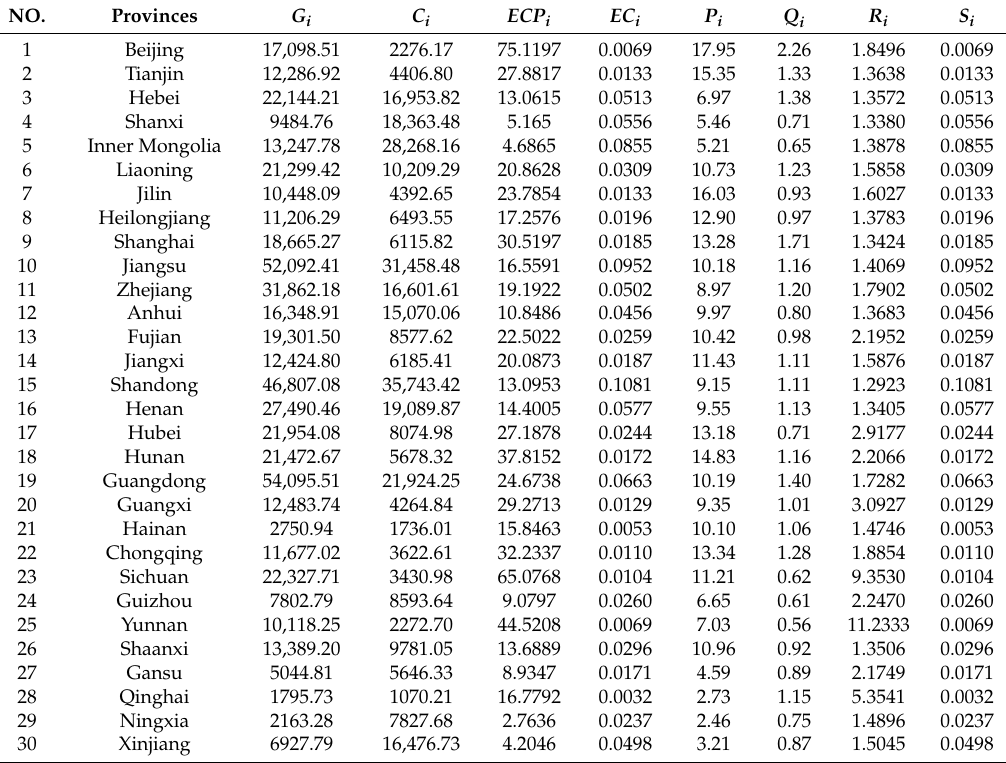
Table A2. The original data for parameters in 2015.